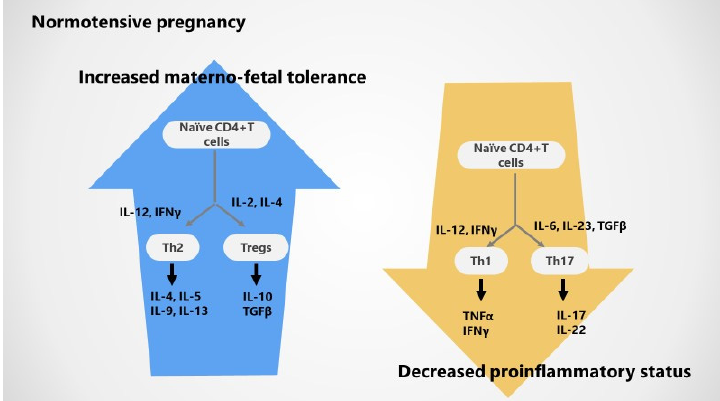
Figure 2. Immunological changes in normal pregnancy; polarized Th2 response with activated Th2–Tregs axis and anti-inflammatory cytokines (IL-4, IL-10) versus inhibited Th1-Th17 cells and their pro-inflammatory cytokines (IL-6, TNF α , IL-1).